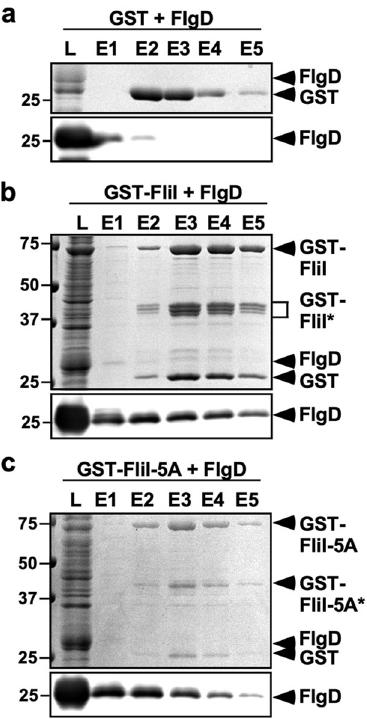
Fig. 6 Effect of the fl iI-5A mutation on the interaction of FliI with FlgD. Cell lysates (indicated as L) prepared from Salmonella SJW1368 ( Δ cheW- fl hD ) cells expressing a GST, b GST-FliI, or c GST-FliI-5A were mixed with those from E. coli BL21 (DE3) cells producing FlgD, and then each mixture was loaded onto a GST column. After washing with 15 ml of PBS, proteins were eluted with 5 ml of 50 mM Tris-HCl, pH 8.0, and 10 mM reduced glutathione. Elution fractions were analyzed by CBB staining (upper panel) and immunoblotting with anti-FlgD antibody (lower panel). The regions of interest were cropped from original CBB-stained gels and immunoblots shown in Supplementary Fig. 11. Three independent assays were